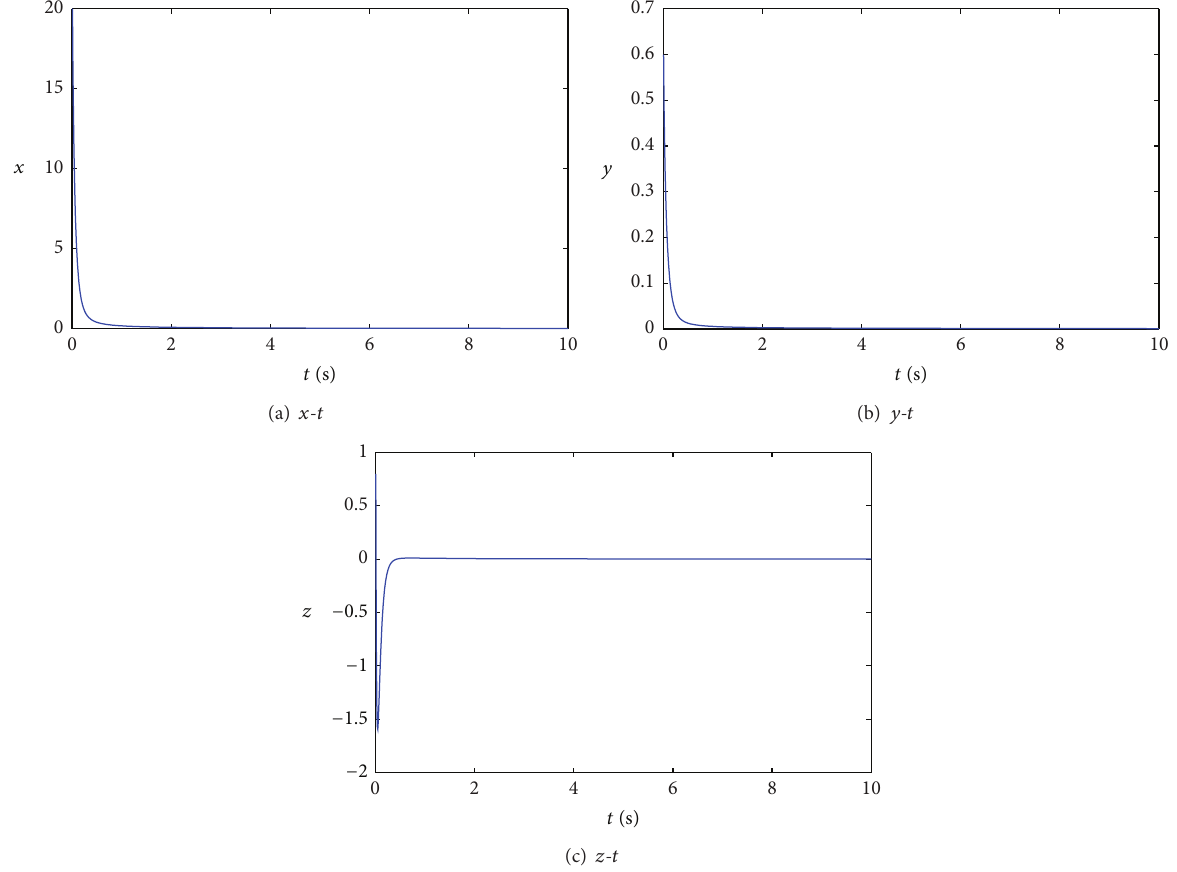
Figure 11: State trajectories of closed-loop system (8) with controller